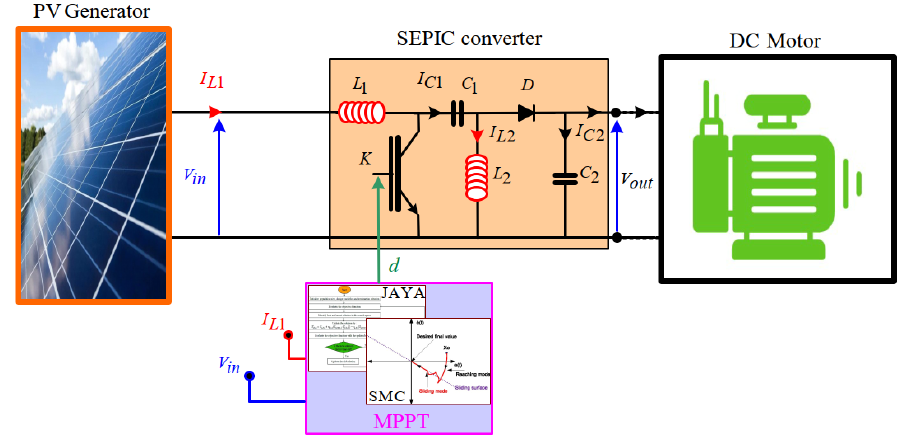
Figure 1. Topology of the studied system.